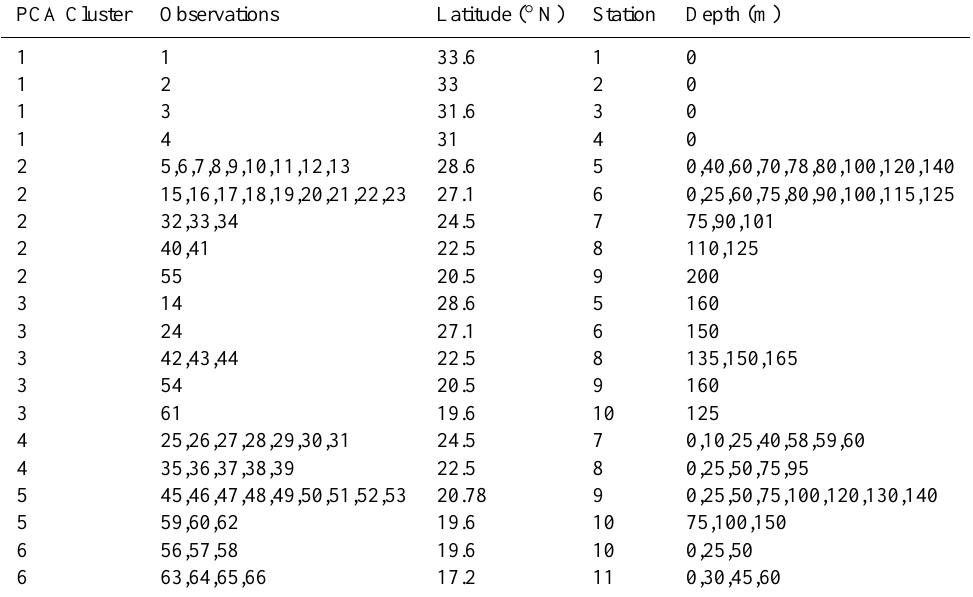
Table 3. List of observations from Stations 1 to 11 and their classification into six clusters according to the principal component analysis (PCA). PCA Cluster Observations Latitude ( ◦